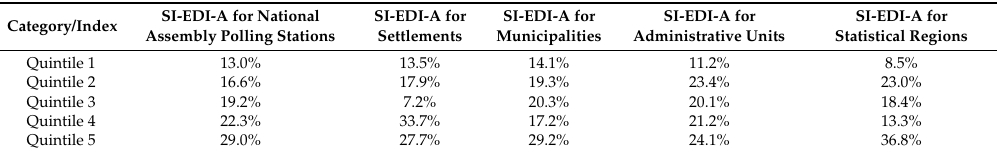
Table 3. Distribution of deprived people ( n = 353,433) according to the SI-EDI-I (quintile 5) into the different quintiles of the ecological deprivation indices (SI-EDI-A).